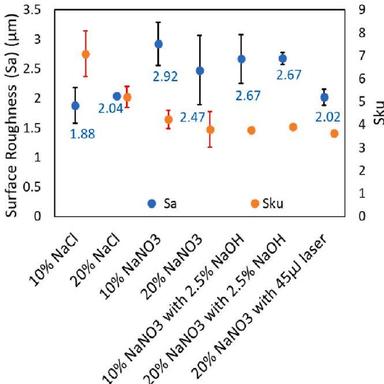
Influence of ECM in different electrolytes and LECM in 20% NaNO3 on surface roughness (Sa) and kurtosis (Sku). Error bars represent σ of 9 measurements.